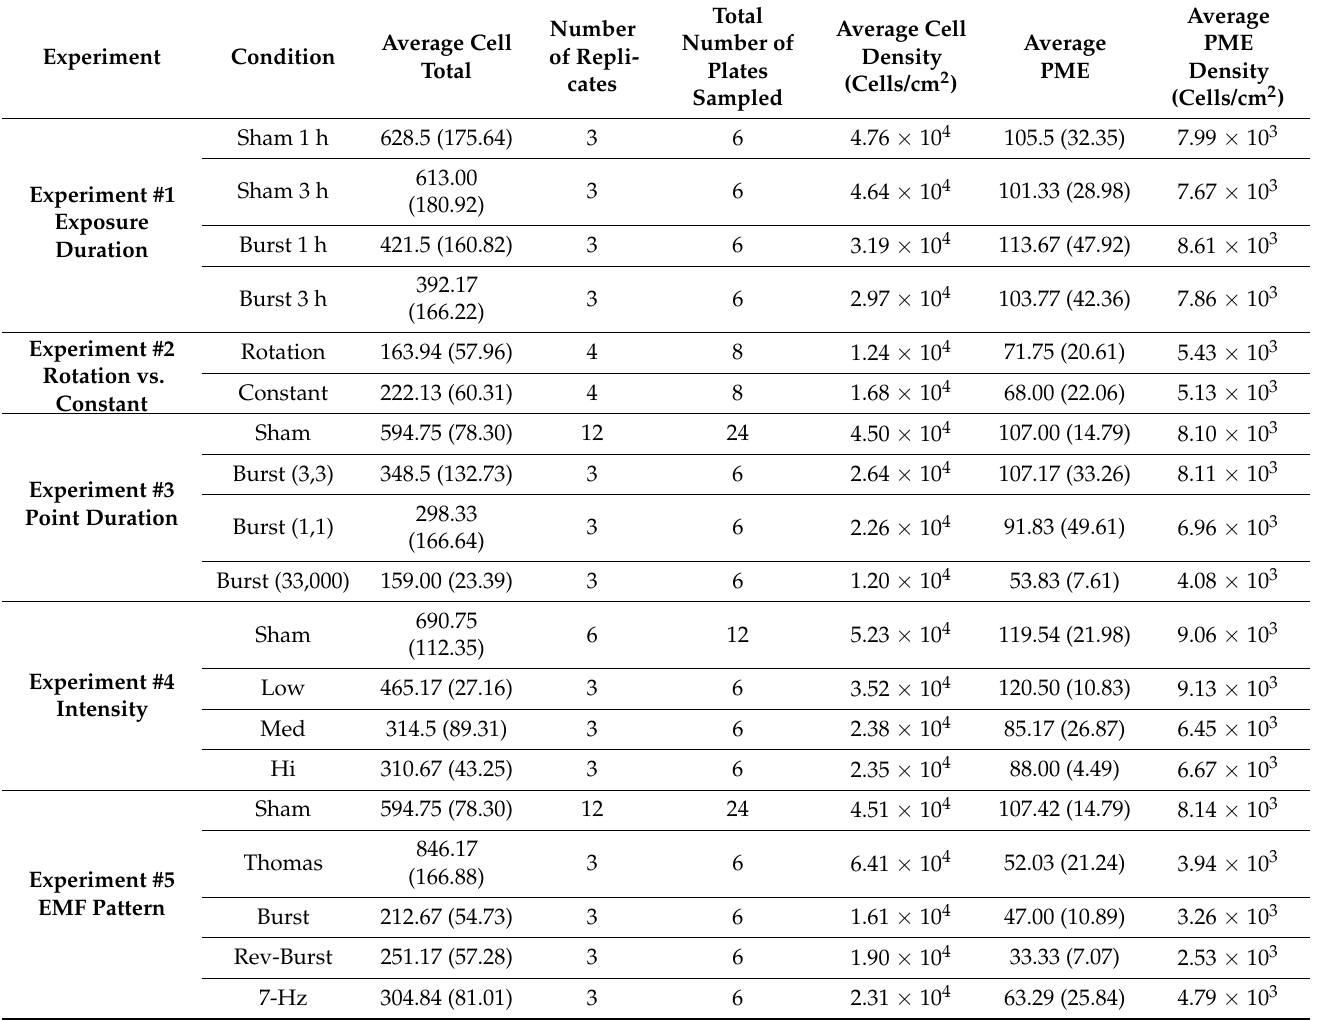
Table 1. The average of the total number of cells counted per field of view, at a magnification of 100 × , average number of PC12 cells bearing plasma membrane extensions (PME), and the computed cell and PME density across each experiment and exposure condition within the experiment. As mentioned previously, sham exposures (control) are PC12 cells treated with forskolin only and all other EMF conditions are samples of PC12 cells treated with both forskolin and exposed to an EMF. For the cell total and PME columns, means and SEM (in brackets) are reported. Measures of density are reported in terms of number of cells/cm 2 . Number of samples refers to the total number of plates exposed to a given condition. In each experiment, 2 plates were exposed in tandem, 4 photos were sampled from each plate for assessment of cell morphology, and a minimum of 3 replications were completed for each condition within a given experiment.